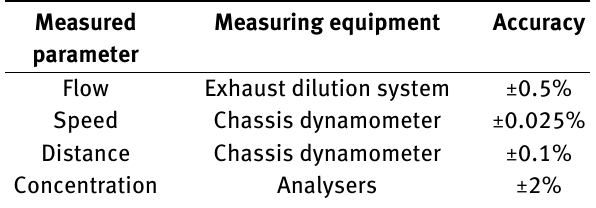
Table 1: Accuracy of the measuring